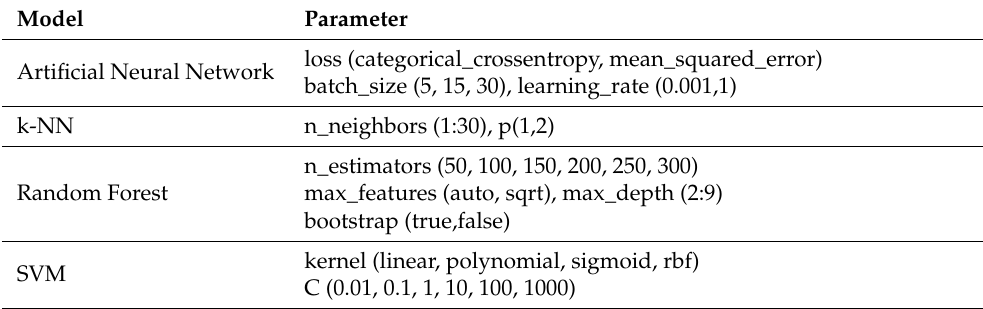
Table 4. Models evaluated in the study and parameters